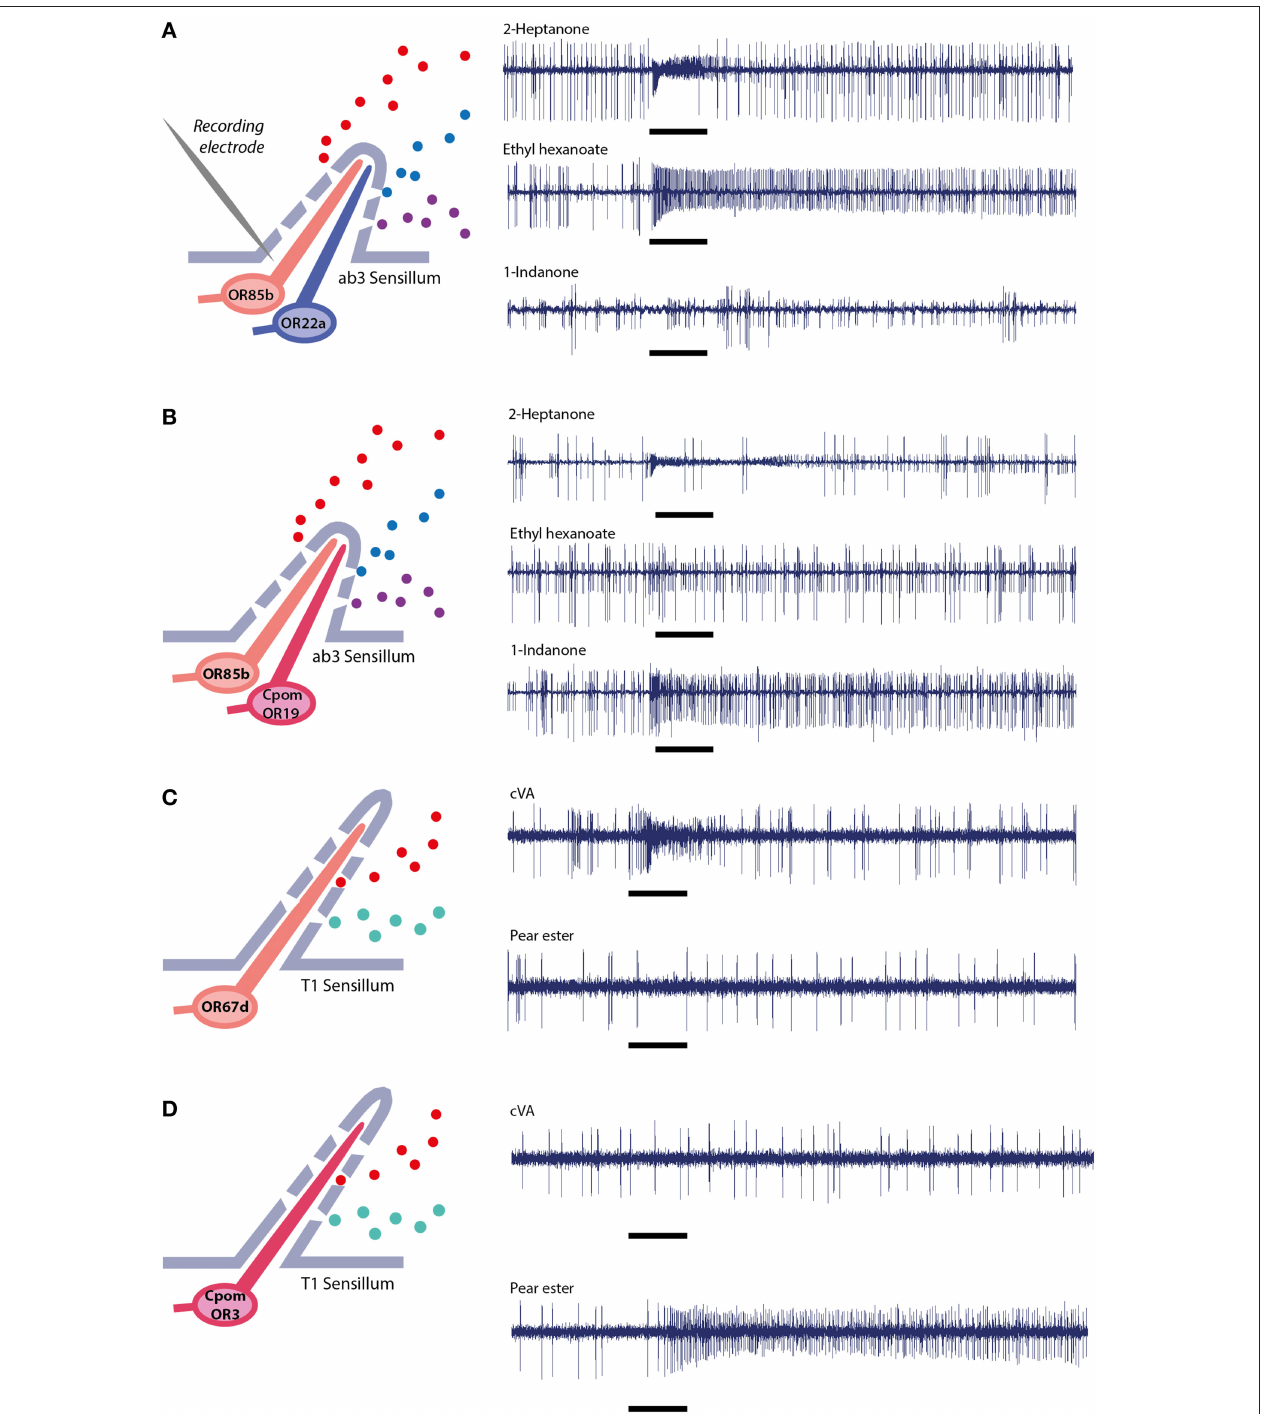
FIGURE 4 | Single sensillum electrophysiological recordings. In ab3 empty neuron system, (A) wild-type flies expressing native ORs, (B) mutant flies expressing native OR85b in the small neuron and transgenic CpomOR19 from C. pomonella in the large neuron ( Gonzalez et al., 2015). In T1 empty neuron system, (C) wild-type flies expressing native OR67d, (D) mutant flies expressing transgenic CpomOR3 (Bengtsson et al., 2014).